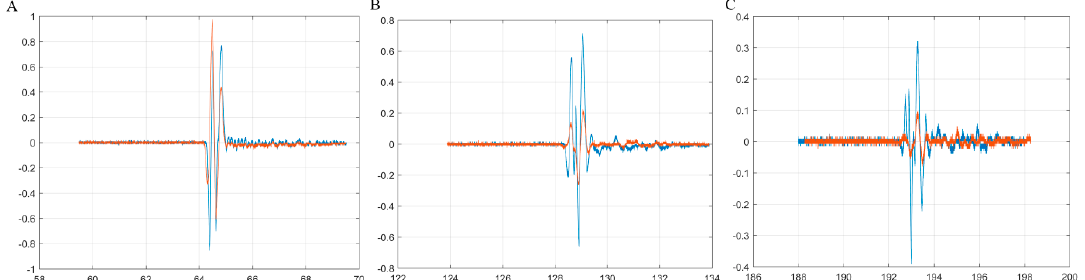
Figure 5. The first three echoes acquired for CD-HAp_2 sample.